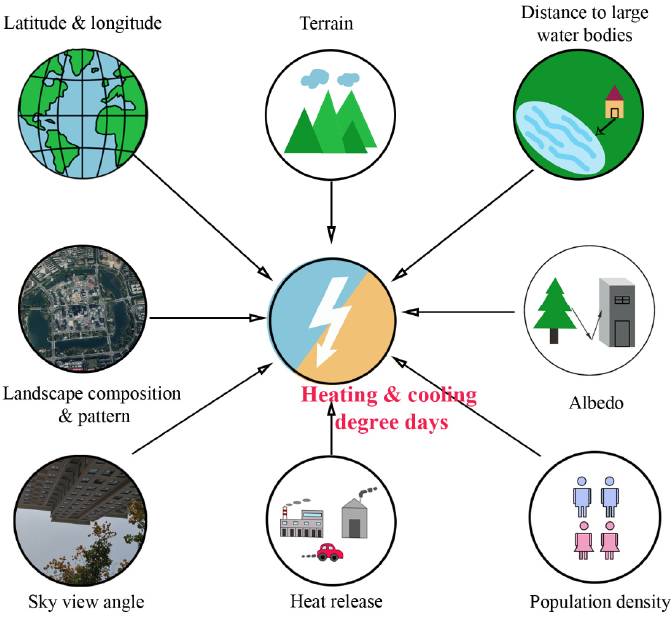
Figure 4. Potential influencing factors of heating and cooling degree days.